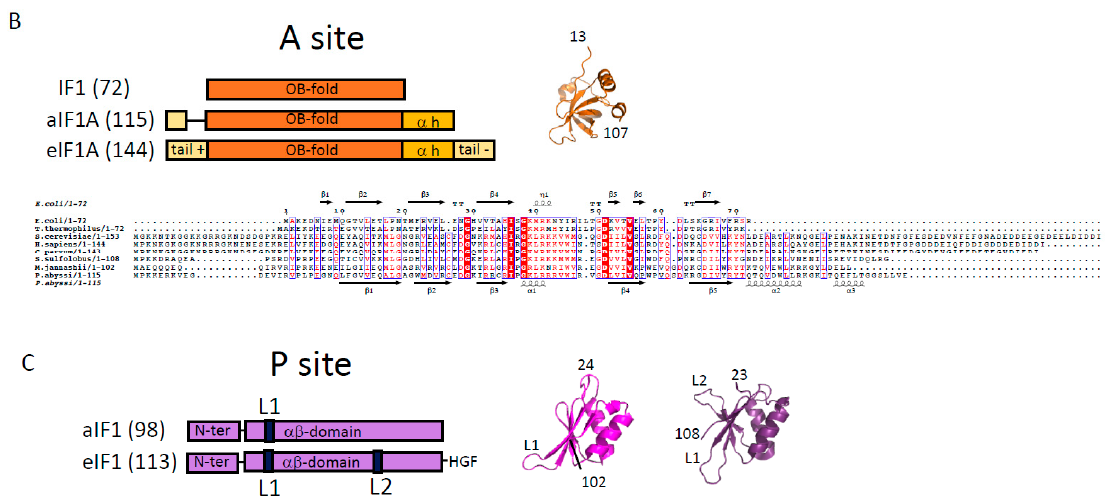
Figure 3. The structure of the initiation factors belonging to the core complex. ( A ) The structural organization of the three subunits of e/aIF2 is shown. Overall, aIF2 α , β and γ from P. abyssi have about 28%, 40%, and 48% sequence identity with the eukaryotic eIF2 α , β and γ subunits, respectively. The eukaryotic specificities of each factor are schematized by dark boxes or indicated within the block with white letters. The eukaryotic eIF2 α have an acidic C-terminal extension. The eukaryotic eIF2 β have a supplementary N-terminal domain necessary for the binding to eIF5 and eIF2B ε . The eukaryotic eIF2 γ have N- and C-terminal extensions compared to the archaeal versions. Note that some eukaryotic and/or archaeal specificities are also found at some positions in the sequences (see text and [66–68] for sequence alignments). The structure of the full heterotrimeric aIF2 is shown in a cartoon representation in its unbound form (left, PDB ID 2AHO and 2QMU) and bound to Met-tRNA iMet (right, PDB ID 3V11). The α subunit is colored in cyan, the β subunit is colored in red and the γ subunit is colored in green. The two mobile wings of aIF2, the α D12 domains and the core domain of β , are circled. ( B ) The structures of e/aIF1A and of its bacterial homologue IF1. The structure of aIF1A from P. abyssi (PDB ID 4MNO) is drawn in orange cartoons. Overall, eIF1A from P. abyssi has about 40% identity with the eukaryotic eIF1A. The basic and acidic eukaryotic extensions necessary for long-range scanning are shown with light yellow boxes. The archaeal version of the factor contains a helix domain at the C-terminal extremity but no acidic extension. However, a short N-terminal tail is present in aIF1A. The organization of the bacterial IF1 protein is also shown. As described in the text, because of their structural resemblance, the IF1 and e/aIF1A proteins are considered as universal initiation factors. The secondary structures are from E. coli IF1 (PDB code 1AH9) and from P. abyssi aIF1A (PDB code 4MNO). ( C ) Structure of e/aIF1. The structure of aIF1 from Methanocaldococcus jannaschii (PDB ID 4MO0) is drawn in magenta cartoons, and that of eIF1 from S. cerevisiae (PDB ID 2OGH) is in purple. Overall, eIF1 from P. abyssi has about 30% sequence identity with the eukaryotic eIF1. The L1 loop, also called a basic loop, is located in front of the anticodon loop of the tRNA in the P IN states of eukaryotes and archaea. The loop is mobile outside of the ribosome (Figure 4). The L2 loop is only present in eukaryotes [72]. It contacts the tRNA D-loop in the P IN state [73]. In all the panels, the numbers of residues indicated in parentheses refer to P. abyssi proteins for the archaea, human proteins for eukaryotes, and E. coli for IF1.